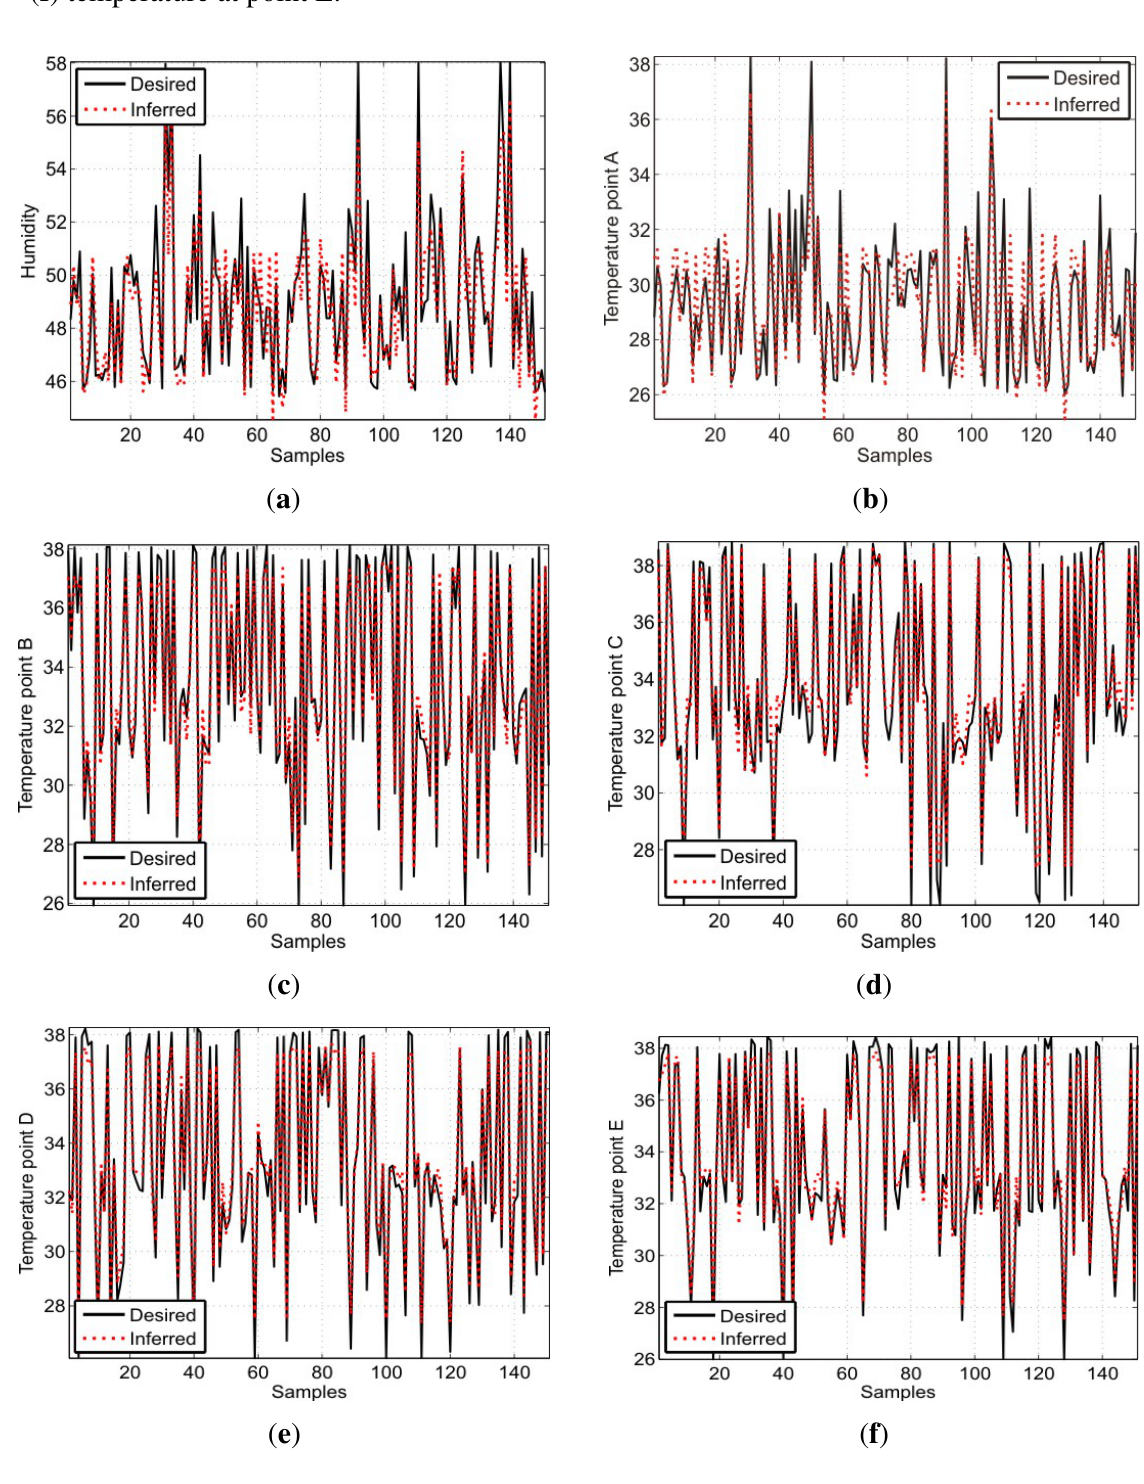
Figure 11. Response of the neural model: ( a ) humidity at point A ; ( b ) temperature at point A; ( c ) temperature at point B; ( d ) temperature at point C; ( e ) temperature at point D; ( f ) temperature at point